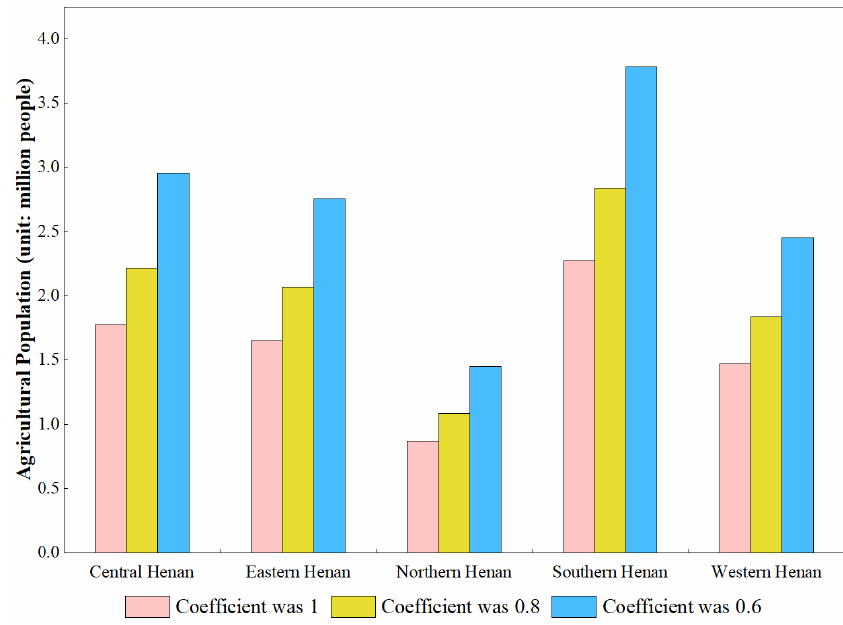
Figure 7. Agricultural population supported by Henan Province.